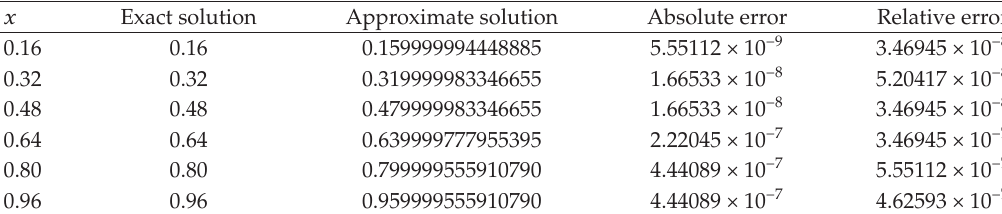
Table 8: Numerical results for Example